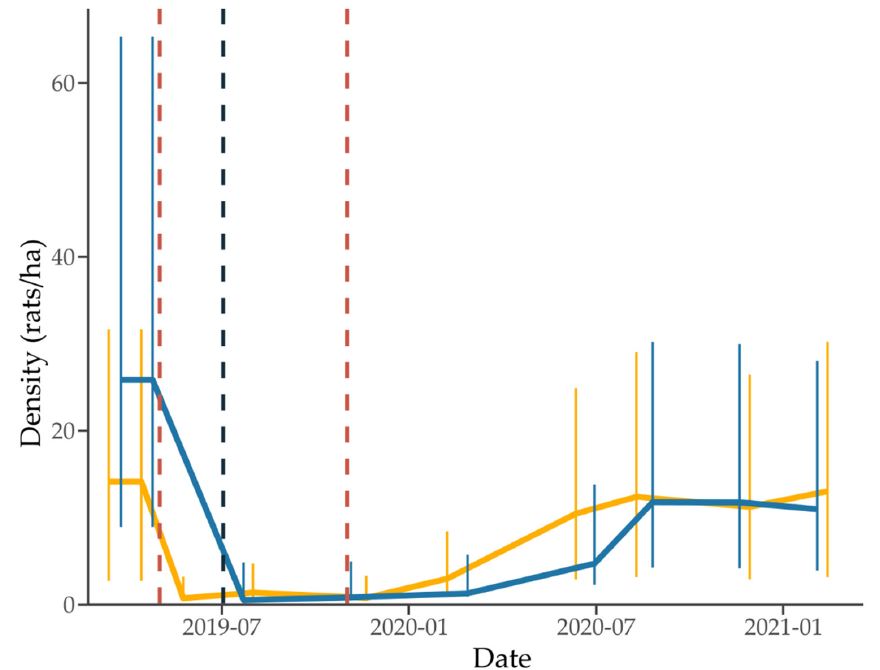
Figure 5. Rat mark-recapture density estimates at the 1080-to-zero (lighter orange) and standard treatment (darker blue) sites. Error bars indicate 95% lower and upper confidence limits. Vertical dashed lines indicate the toxic application at each site (lighter red for 1080-to-zero and darker blue for standard).